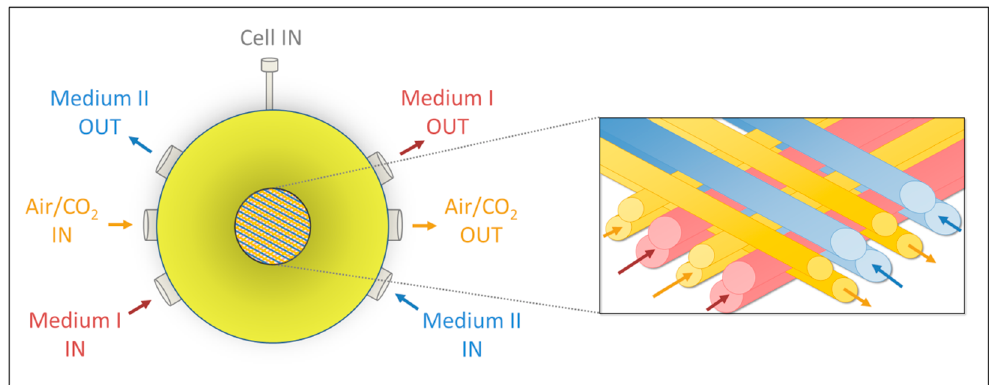
Figure 1. Schematic illustration of the three-dimensional (3D) multi-compartment hollow-fiber bioreactor technology. The bioreactor consists of three independent bundles of hollow fiber membranes interwoven in four layers. Each layer is composed of alternately arranged medium and gas capillaries. The two medium-carrying bundles ( red and blue ) are perfused in a counter-current way to enhance mass exchange. The third bundle ( orange ) serves for gas supply of the cells cultured between the capillaries.